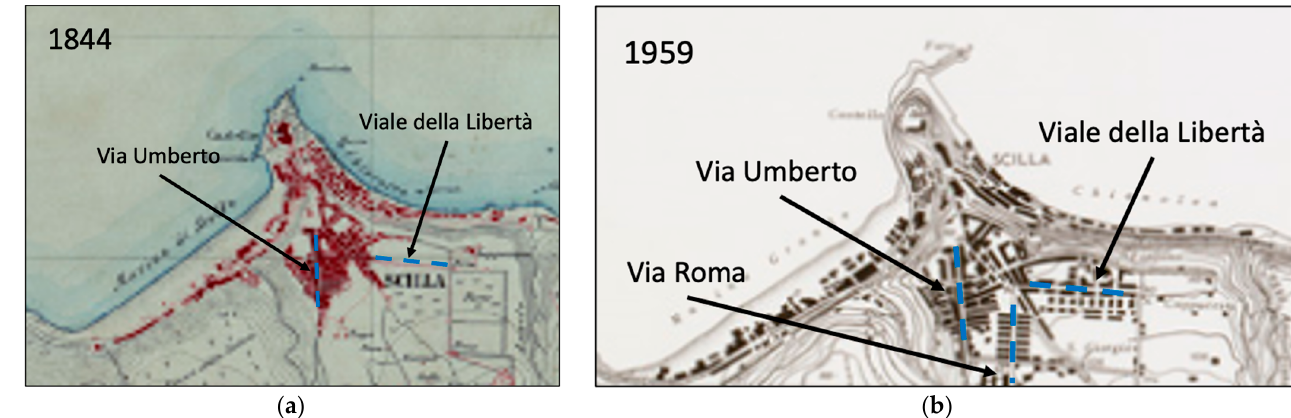
Figure 3. Historical maps made available by the Italian Geographic Military Institute (IGM). ( a ) Historical map of scilla dating back 1884. ( b ) Historical map of Scilla dating back 1959.